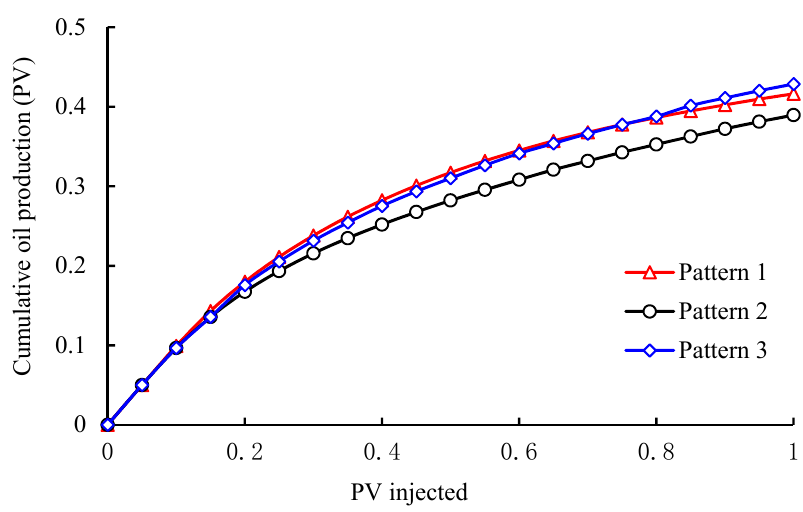
Figure 16. Cumulative oil production variation under different fracture spacings.